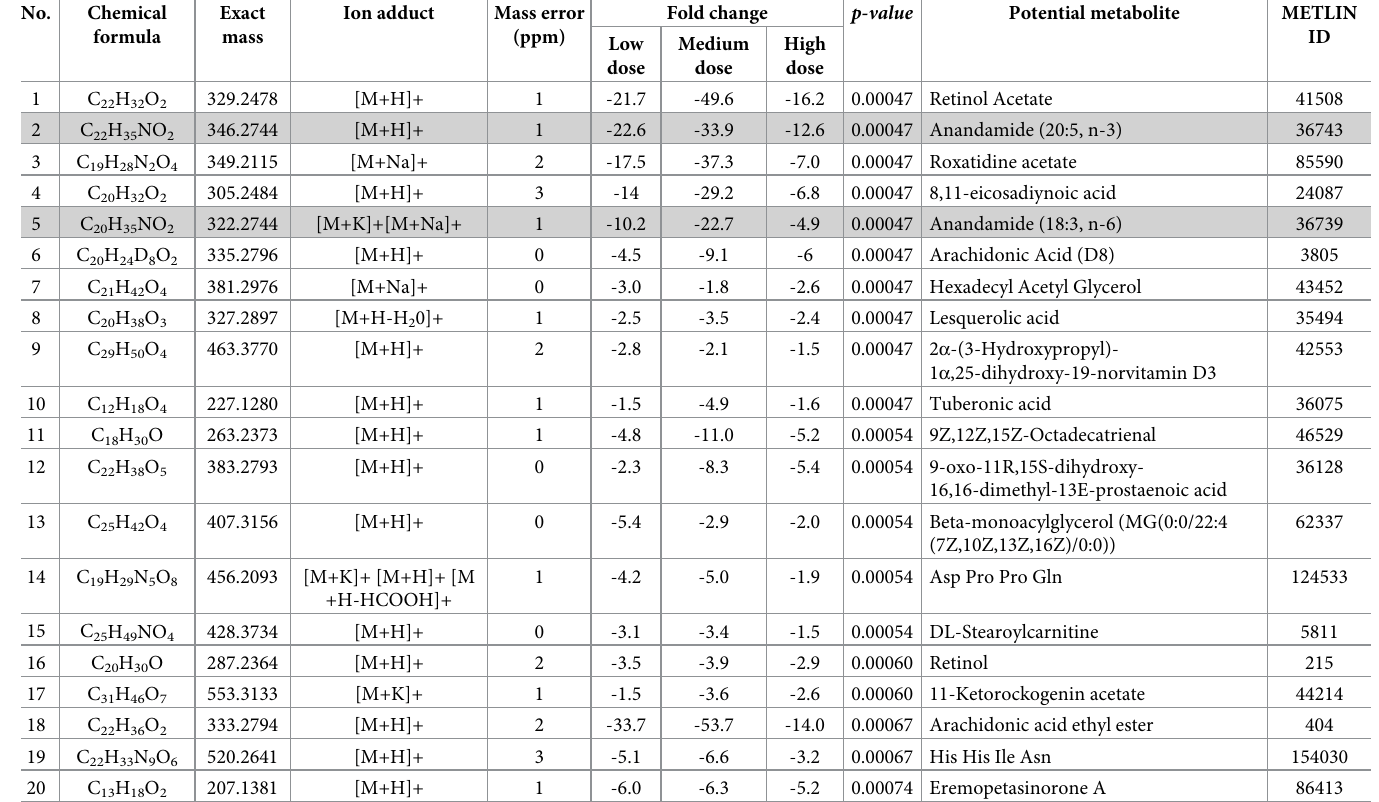
Table 2. Top 20 metabolites of S . mekongi with decreased level after PZQ treatment by multivariate analysis.